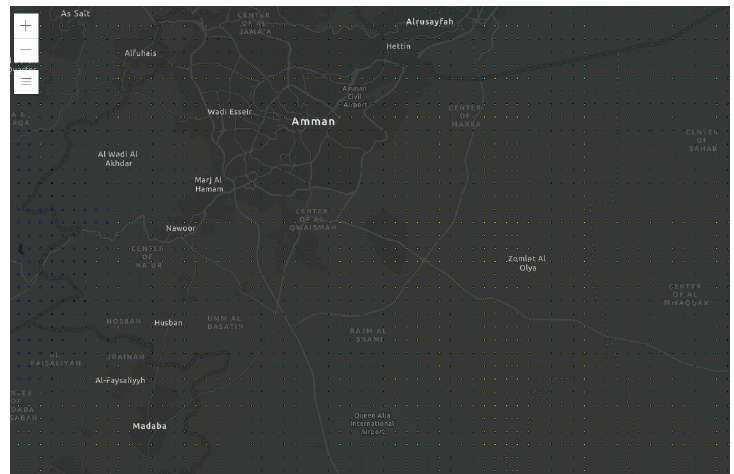
Figure 9. Zoom in/out feature.